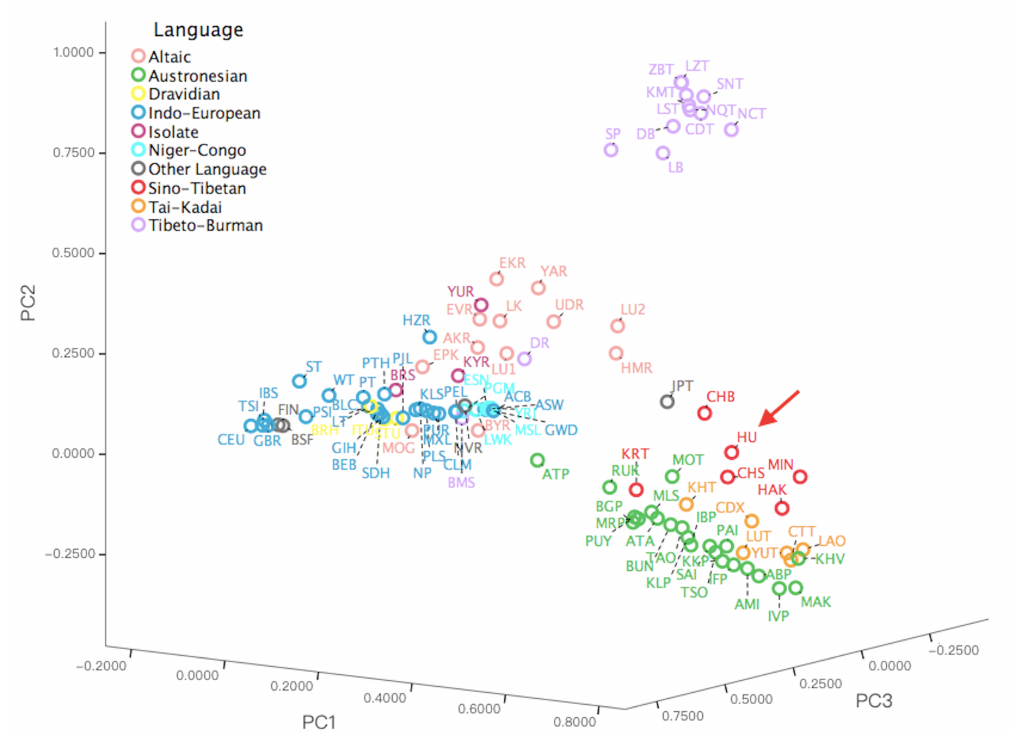
Figure 2. A principal component analysis (PCA) plot showing the genetic relationships between populations based on the haplogroup frequencies of 7372 complete mitochondrial sequences from 100 worldwide populations, the Hui group, and 99 reference populations. The red arrow refers to the studied Hui group (HU). The geographical origins of 100 populations in the plot are listed as